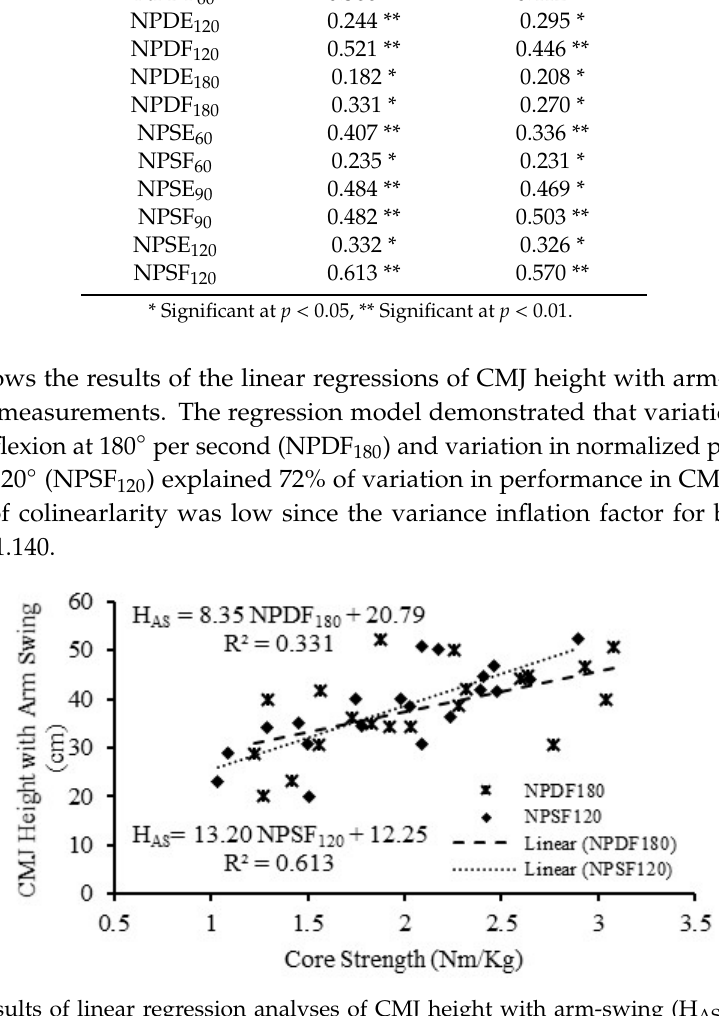
Table 2. Shared variance (R 2 ) between CMJ height and core strength measurements (n = 20).